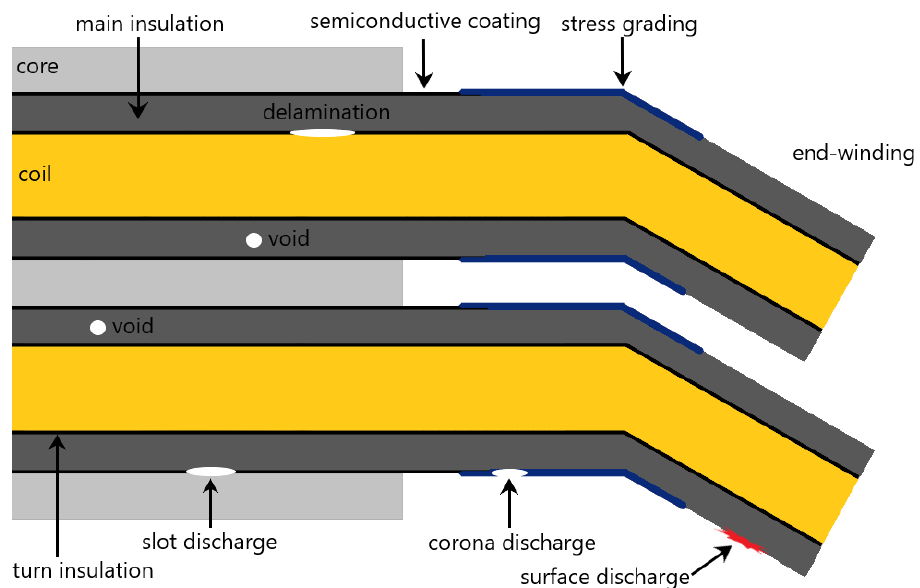
Figure 3. PD sources in the isolation system of a typical